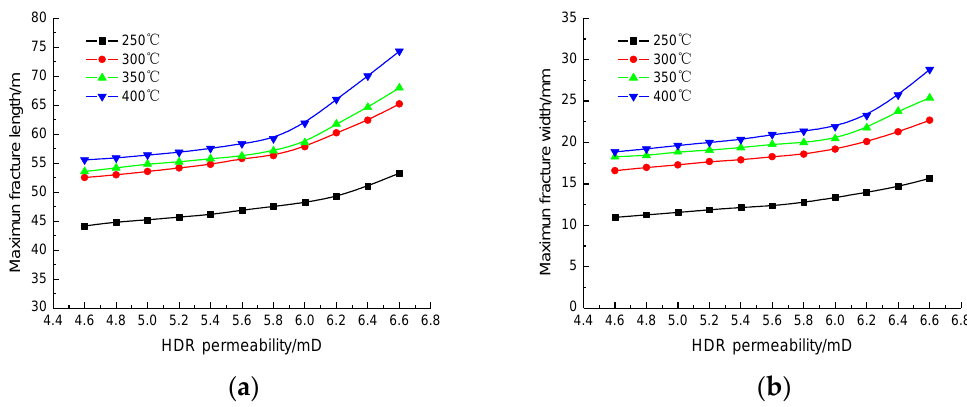
Figure 12. The relation between fracture length and width and HDR reservoir permeability. ( a ) Fracture length curves. ( b ) Fracture width curves.